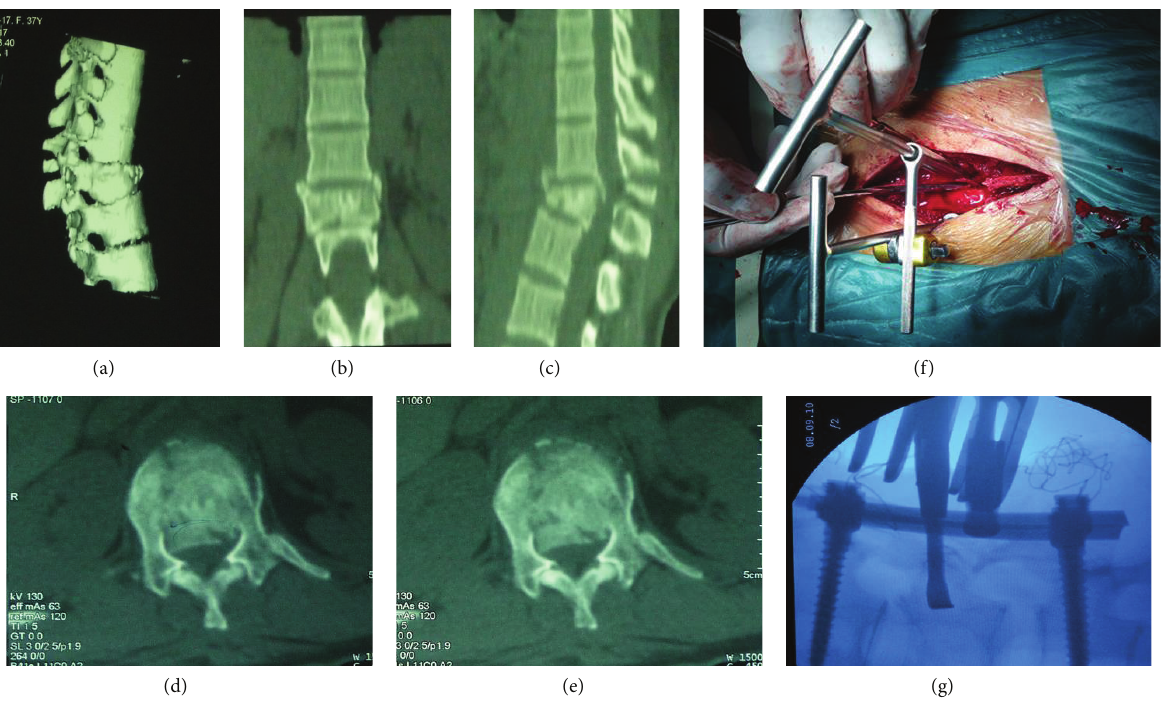
angle was 17.2 degree ( ± 6.87 degrees), whereas it decreased